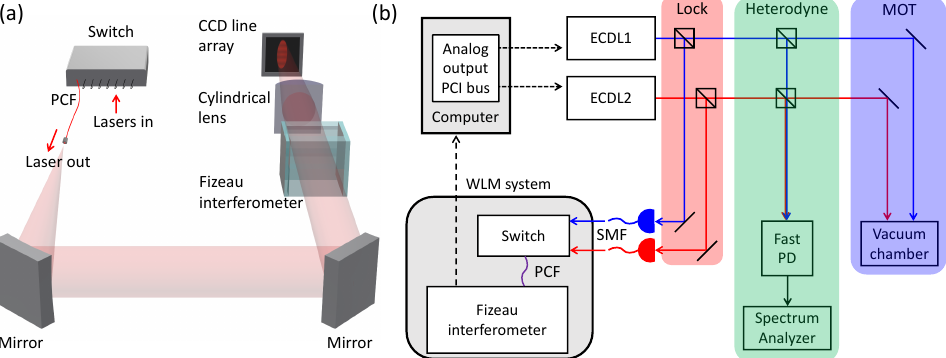
Figure 1. ( a ) Wavelength meter (WLM) system. Photonic crystal fiber (PCF); Charge-coupled device (CCD). ( b ) Experimental setting. Laser output is distributed to three optical paths: locking laser frequency, heterodyne spectroscopy, and generation of magneto-optical trap (MOT). Peripheral component interconnect (PCI); External cavity diode laser (ECDL); Photodiode (PD); Single mode fiber (SMF). Blue and red solid lines refer laser fields and black dashed lines indicate electronic